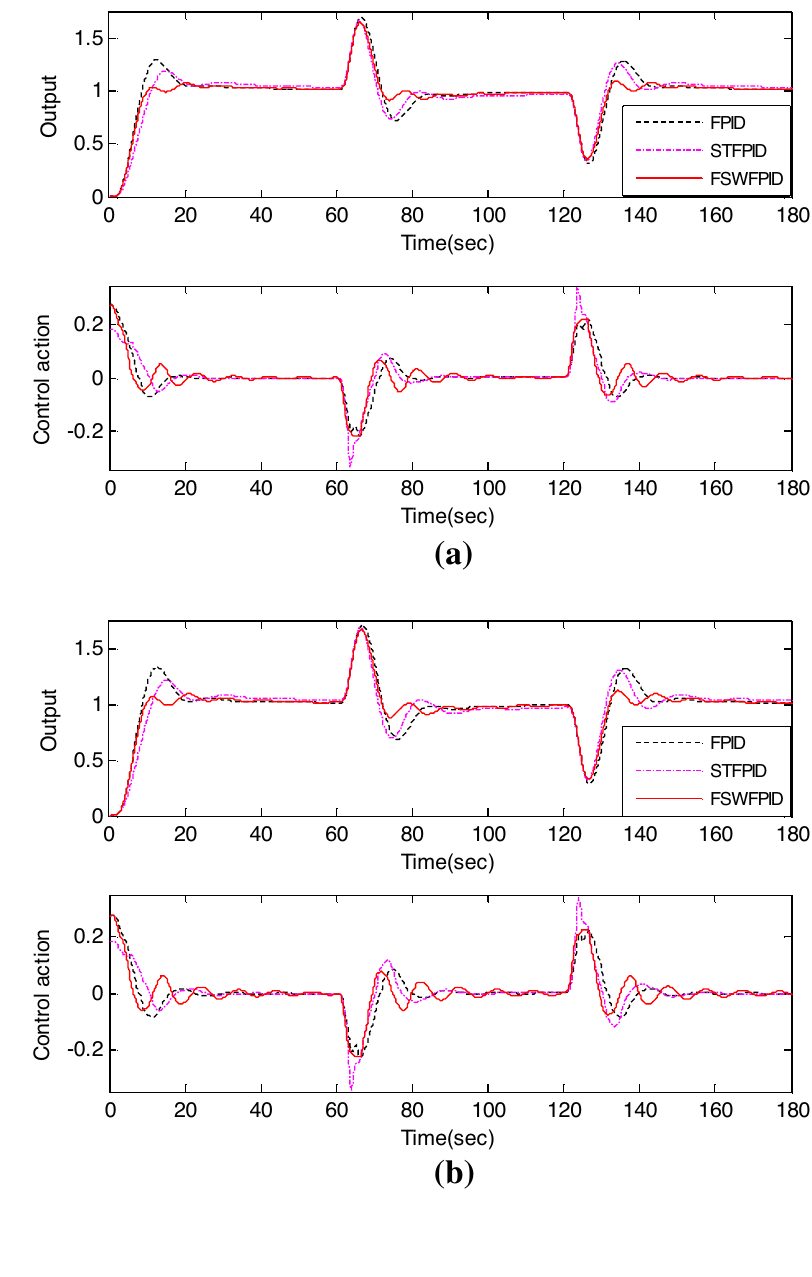
Fig. 12 Responses and control actions for Model III using 49 rules during set point response and with load variation for a L = 0.3 s, b L = 0.05